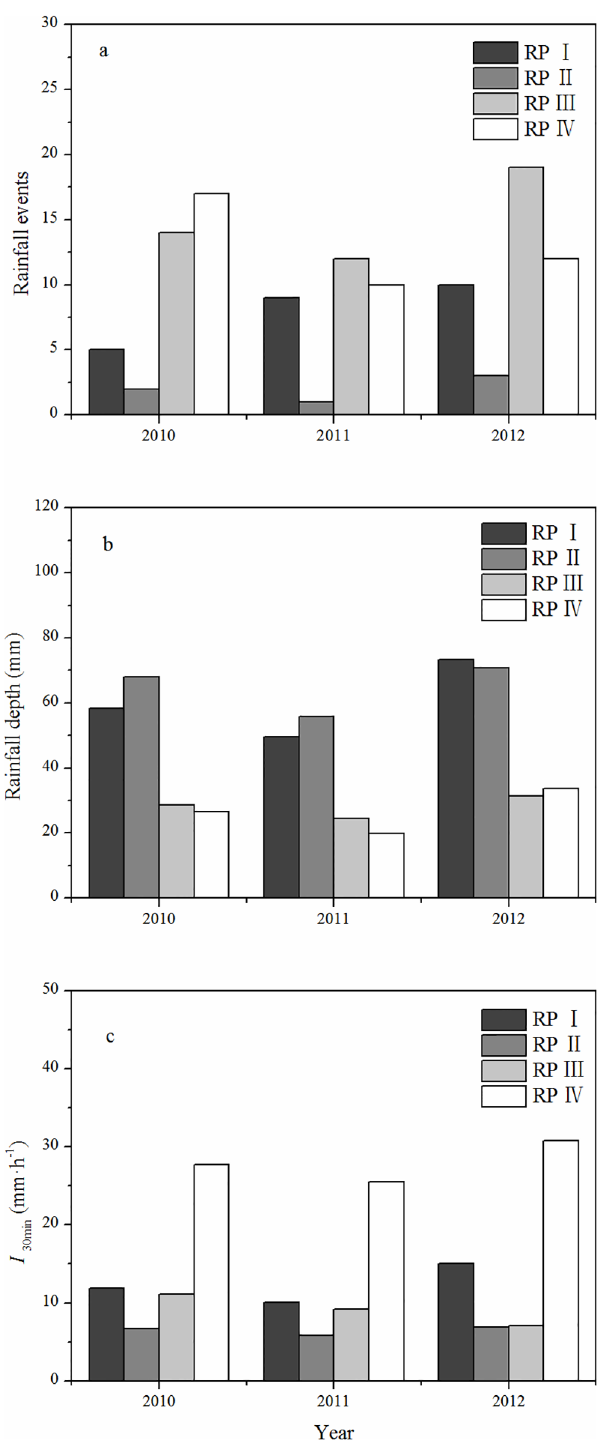
Fig 2. Rainfall pattern characteristics for events from 2010 to